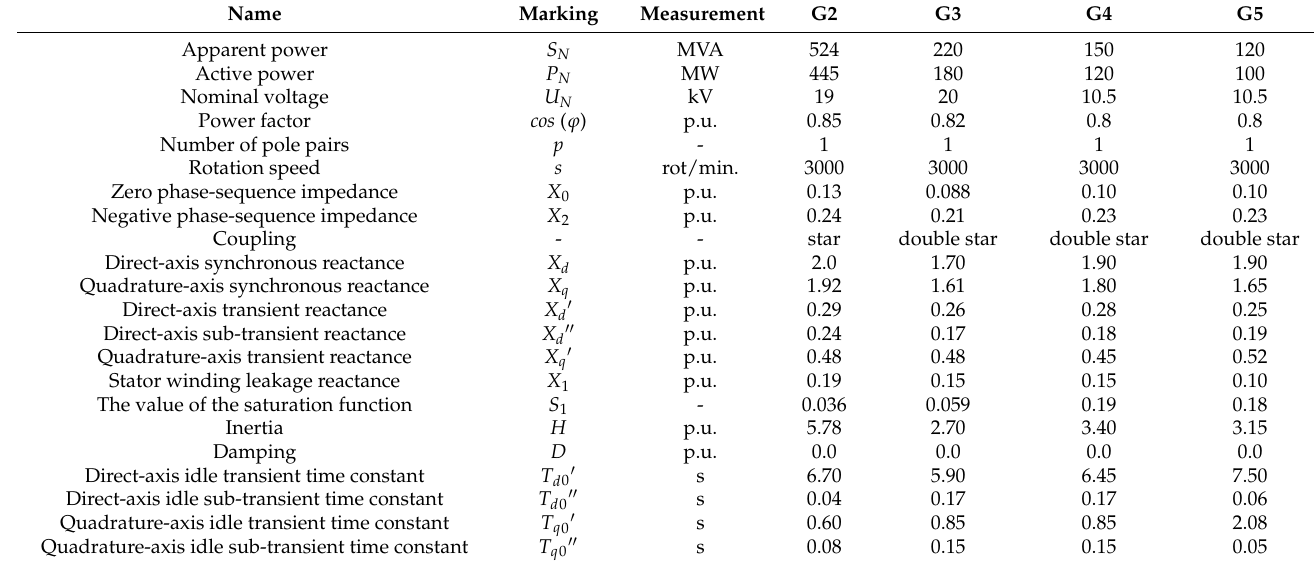
Table 2. Main parameters of turbogenerators